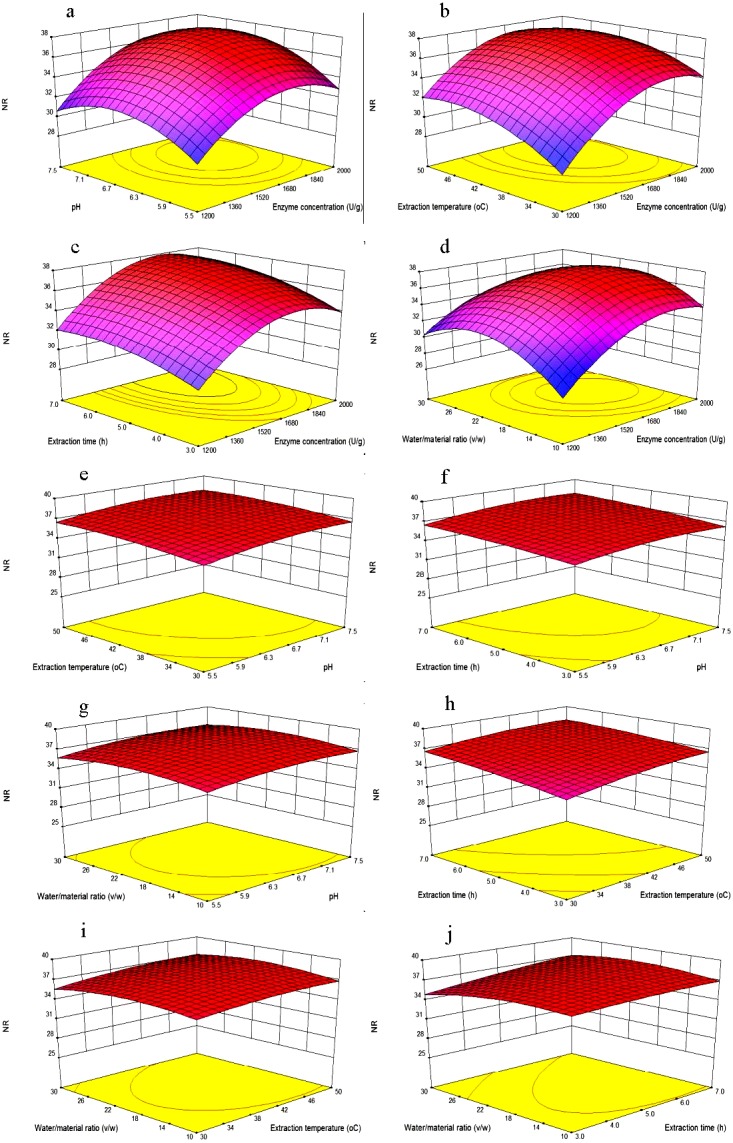
Response surface plots showing the effects of variables.Each figure meant as follows: (A) Effects of enzyme concentration and pH; (B) enzyme concentration and extraction temperature; (C) enzyme concentration and extraction time; (D) enzyme concentration and water/material ratio; (E) pH and extraction temperature; (F) pH and extraction time; (G) pH and water/material ratio; (H) extraction time and extraction temperature; (I) extraction temperature and water/material ratio; (J) extraction time and water/material ratio on the NR of MVH; NR, nitrogen recovery.